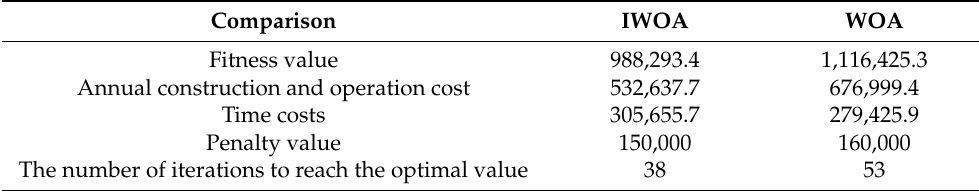
Table 7. Performance comparison for IWOA and other improved